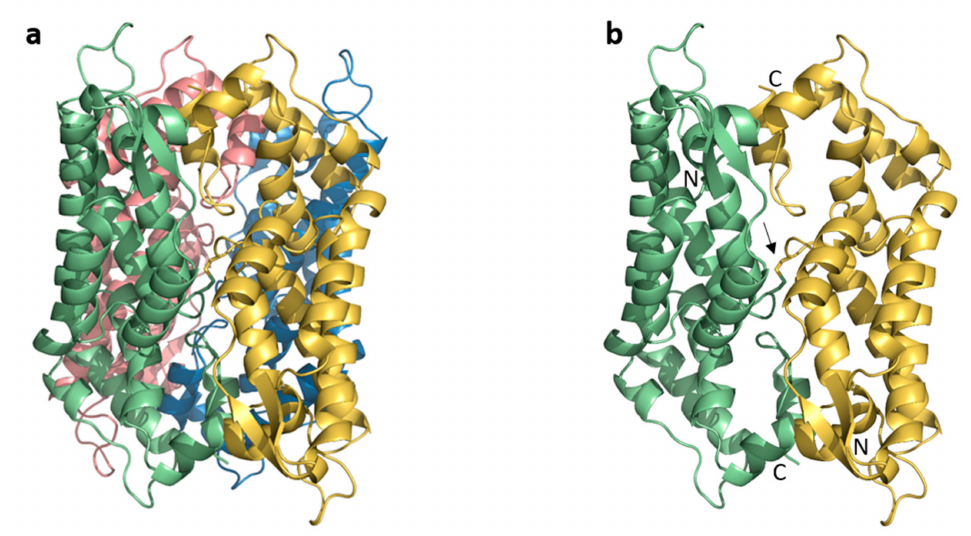
Figure 1. Crystal-packing interfaces and assembly of FIV CA. ( a ) Tetrameric packing of FIV CA protein (chain A: yellow, chain B: green, chain A (cid:48) : blue and chain B (cid:48) : pink); ( b ) A-B dimer in the asymmetric unit. The disulfide bridge between chains A and B is labeled with an